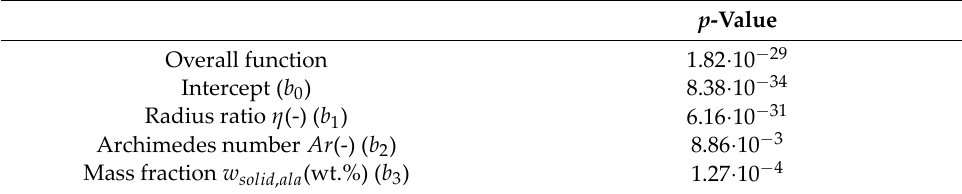
Table 3. p ‑Values of the regression according to the model Equation Table 3. 𝑝 -Values of the regression according to the model Equation (6).